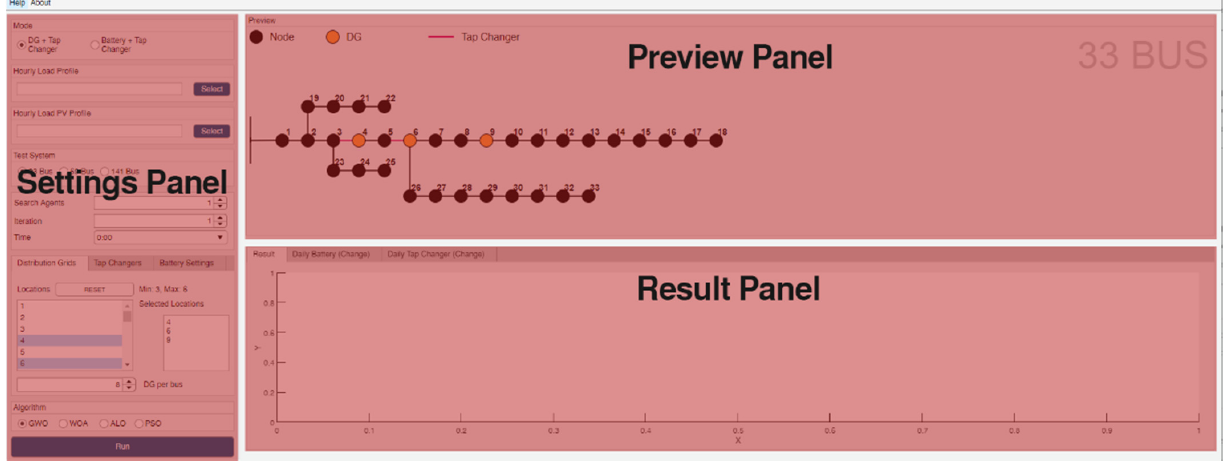
Figure 3. Placement of three panels on the application.